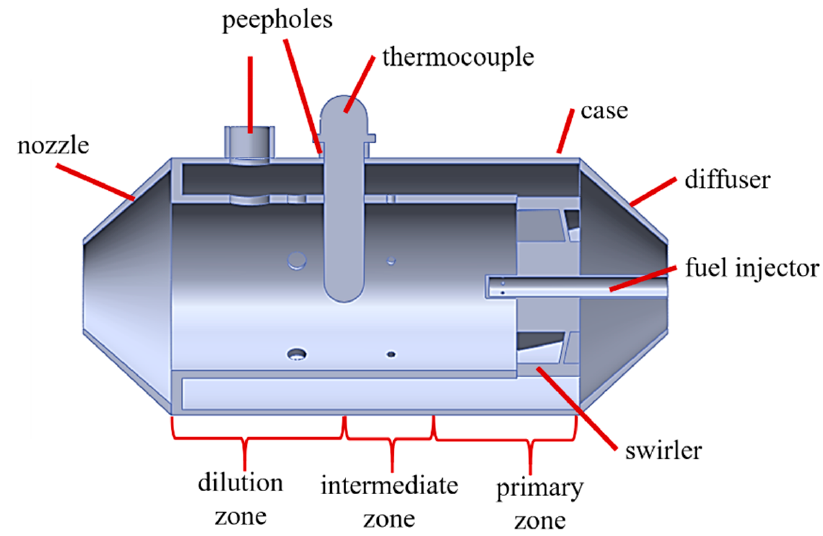
Figure 1. Non-premixed flame combustion chamber with swirler.